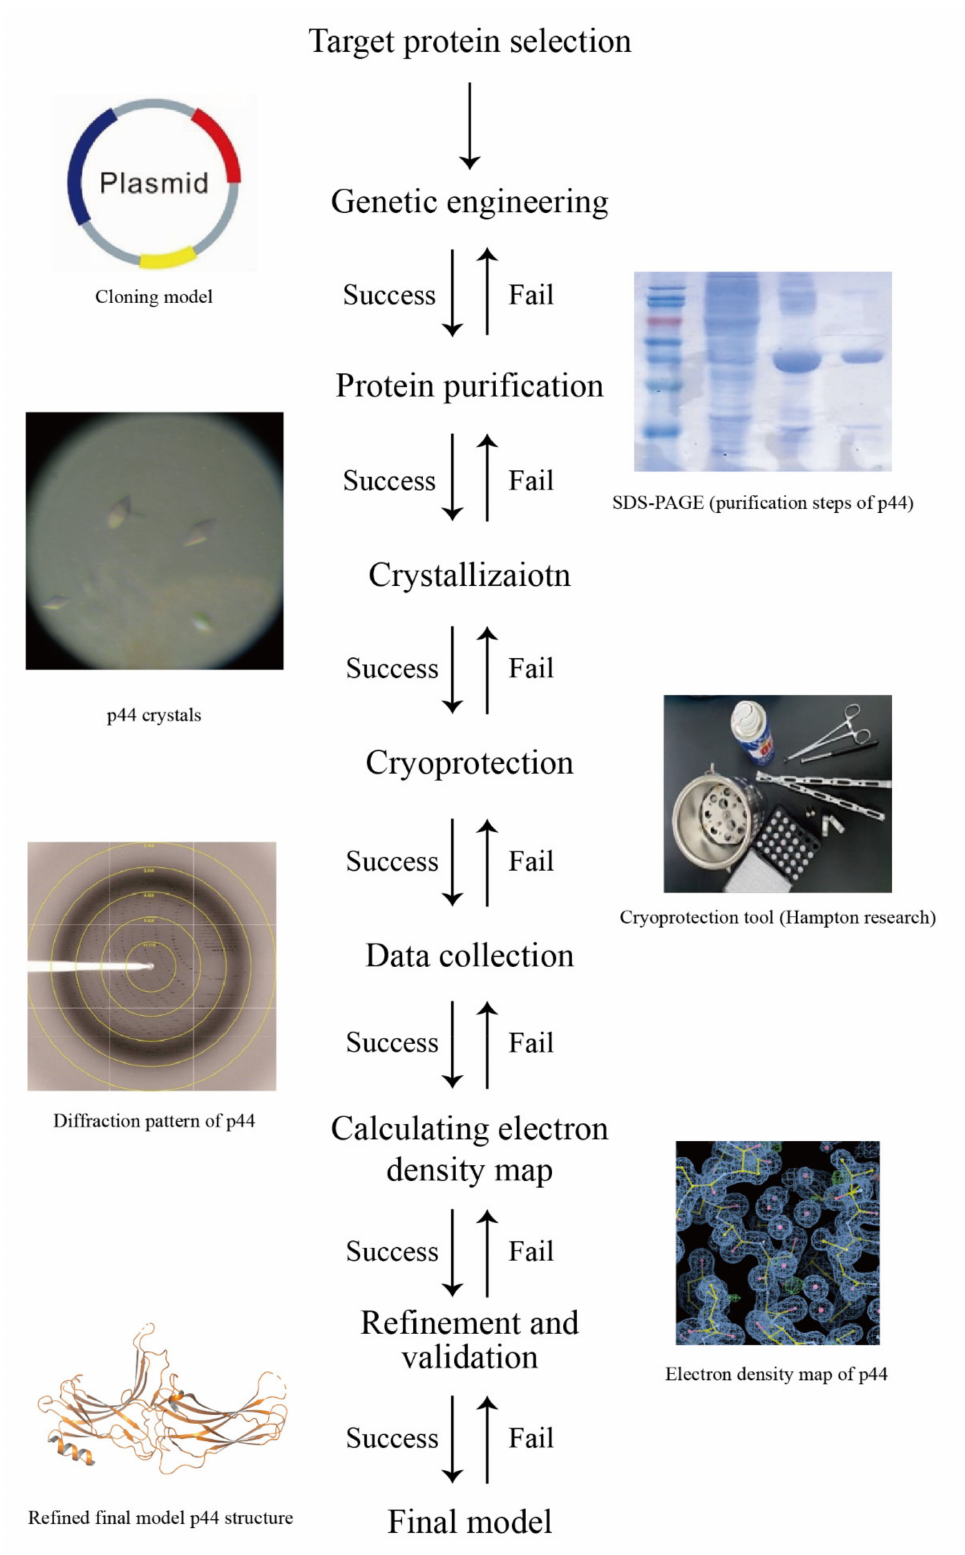
Figure 1. Overall processes of protein structure analysis using X-ray. p44 (PDB entry: 4J2Q [9])